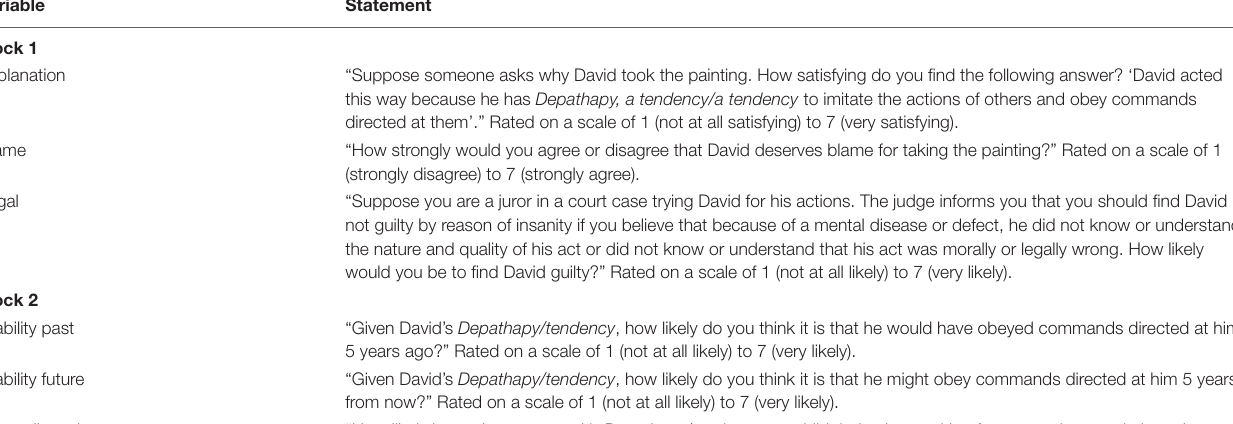
TABLE 2 | The list of the